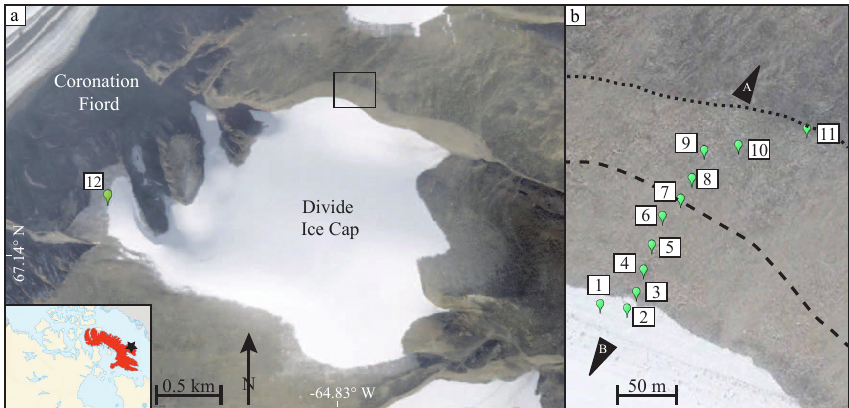
Figure 1. (a) A map view of Divide Ice Cap, with location in inset map; note prominent asymmetric trimlines and location of sample #12. (b) Detail of sampling transect along which mosses were collected (sample numbers noted), with trimline (dotted line) and 1960 ice margin (dashed line; based on aerial photographs) shown. Locations of camera angles for Fig. 2 are also noted with black triangles with panel letters. Imagery courtesy DigitalGlobe (2011).